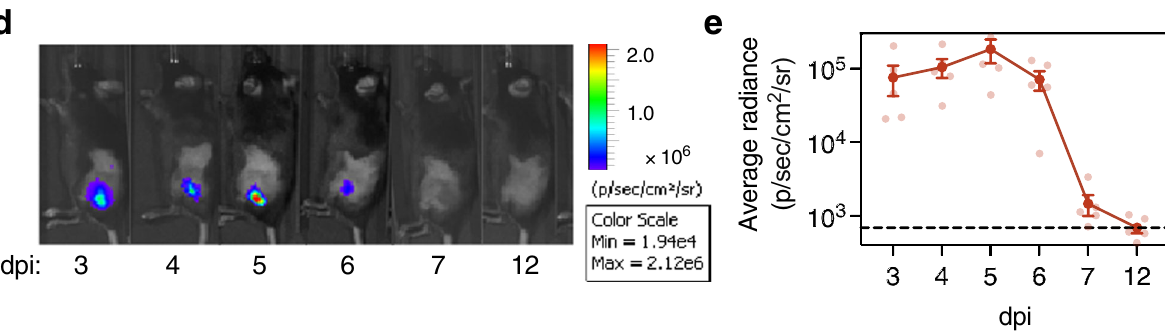
Fig. 2 Expression kinetics and biodistribution of antigen in mice immunized with LV-CMV-nLuc or LV- β 2m-nLuc. a Lateral view of C57BL/6 mice ( n = 3/experimental group and n = 2/control group), immunized i.m. with 5 × 10 7 TU of LV-CMV-nLuc, LV- β 2m-nLuc, or LV-GFP as a negative control. Furimazine substrate (4 mg/kg) was injected i.p. right before imaging at 5, 7, 9, 12, and 14 dpi. Bioluminescence images indicate the location of nLuc. b Mean bioluminescence signal in C57BL/6 mice immunized i.m. with 5 × 10 7 TU of LV-CMV or LV- β 2m encoding nLuc. c Representative bioluminescence images of tissues and organs of C57BL/6 mice ( n = 3/experimental group and n = 2/control group) at 5 dpi with 5 × 10 7 TU of LV-CMV-nLuc, LV- β 2m- nLuc, or LV-GFP as a negative control. LN lymph node. d Lateral view of C57BL/6 mice ( n = 5) immunized i.m. with 5 × 10 7 TU of LV- β 2m-nLuc and was imaged at 3, 4, 5, 6, 7, and 12 dpi. e The mean bioluminescence signals of mice immunized with LV- β 2m-nLuc. For ( b ) and ( e ), the dotted line represents the background level determined from mice immunized with LV-GFP and had received furimazine substrates upon imaging. Each point represents the mean bioluminescence signal (p/s/cm 2 /sr) per group, expressed as mean ± SEM. Smaller dots represent biological